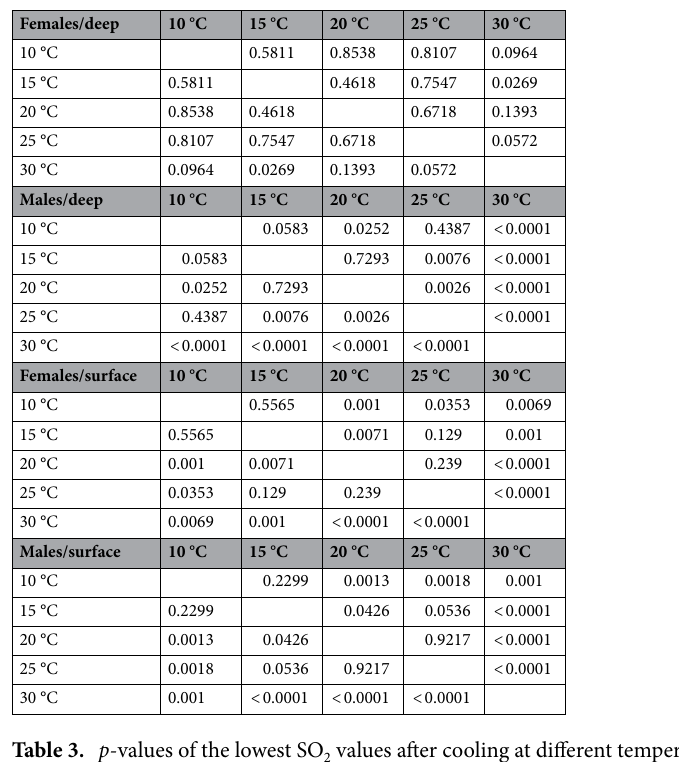
temperature, a difference between the initial and resulting flow values after 60 min existed. An increase in blood flow and thus reactive hyperemia was recorded for every temperature except 20 °C (Table 2). The smallest increase in blood flow, 5.09 AU in the deep tissues, and even a decrease of 3.19 AU at the surface were achieved with the 20 °C cooling temperature (Table 2). Saturation of oxygen. The females’ post-cooling SO 2 values for each temperature were lower than the initial values (Fig. 2b). The lowest SO 2 values achieved with 10 °C and 30 °C were those for the deep tissues 15 min after cooling. At the surface, the deepest SO 2 values were measured at 15 min after cooling at 10 and 15 °C. A significant difference between the lowest SO 2 values in the deep tissues were observed for 15 °C and 30 °C ( p = 0.0269). There were statistically significant differences in the lowest SO 2 values for each temperature measured at the surface (Table 3). The males’ post-cooling SO 2 values for each temperature were lower than the initial values (Fig. 2b). Haemoglobin concentration. In the females, cooling at each temperature led to lower Hb than those initially measured (Fig. 2c). Immediately after cooling at 10 °C, 15 °C, 20 °C and 25 °C, there were no statistically significant differences in the deep tissue Hbs (Table 4). The deep tissue values indicated that the Hbs immediately after cooling at 30 °C were significantly higher than those observed at the lower temperatures. The Hb values after cooling at 25 °C were significantly lower than those at all the other temperatures except 15 °C (Table 4). The lowest Hb values at the surface were not obtained directly after cooling for any of the cooling temperatures. The lowest Hb value for 10 °C was recorded 30 min after cooling, and for 15 °C, it was 15 min after cooling. The males’ post-cooling Hbs for each temperature were lower than the initial values (Fig. 2c). The lowest Hbs after cooling at 30 °C were significantly different from those achieved at the other temperatures (Table 4). The lowest post-cooling surface Hbs at 10 °C, 15 °C and 30 °C were measured at 15 min after each application. Satisfaction with cooling. The participants’ satisfactions showed statistically significant differences in the females’ satisfaction levels ( p < 0.0001, 30 °C vs. 25 °C: p = 0.0147; Fig. 3a; Table 5). The significant differences in the males’ satisfaction values for the cooling temperatures were observed for 10 °C vs. 15 °C and 15 °C vs. 20 °C (10 °C vs. 15 °C: p = 0.0072, 15 °C vs. 20 °C: p = 0.0131; Table 5). Both sexes were most comfortable with 25 °C cooling temperature and satisfaction decreased with lower temperatures. The decrease in satisfaction in the females was greater than that in males (Table 5, Fig. 3a). Between both sexes, there were significant differences in the satisfaction at the 10 °C, 15 °C, 20 °C and 25 °C temperatures (10 °C: p < 0.0001, 15 °C: p < 0.0001, 20 °C: p = 0.0168, 25 °C: p = 0.0293). The difference in the satisfaction values for 30 °C was not significant ( p = 0.5439).